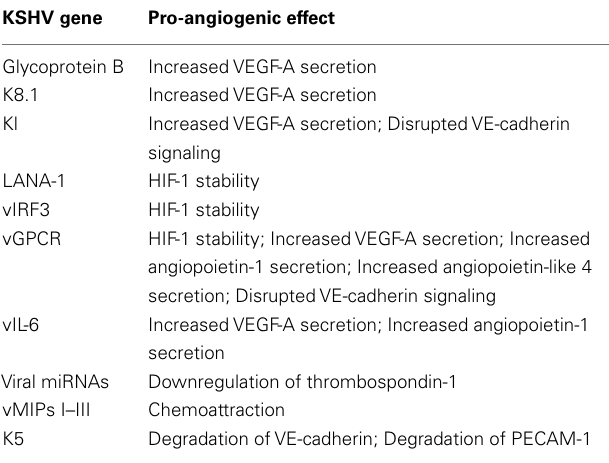
Table 1 | KSHV genes involved in the induction of angiogenesis. KSHV